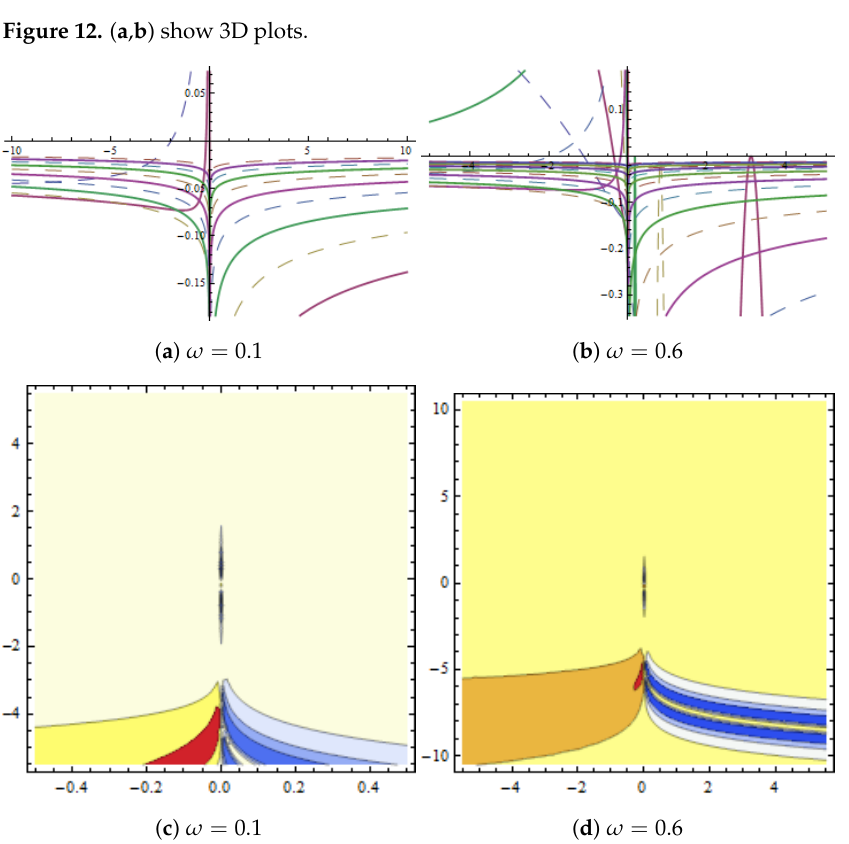
Figure 13. Dynamical behaviour of u ( x , t ) in Equation (38) presented with β 1 = 0.3, β 2 = 2.2, β 3 = 0.5, β 4 = 5.4, ζ = 0, Q = 2, w 2 = 1.1, w 3 = 3.2 and φ = 1.4. ( a , b ) show 2D plots and ( c , d ) repre- sent contour plots for different values of ω .